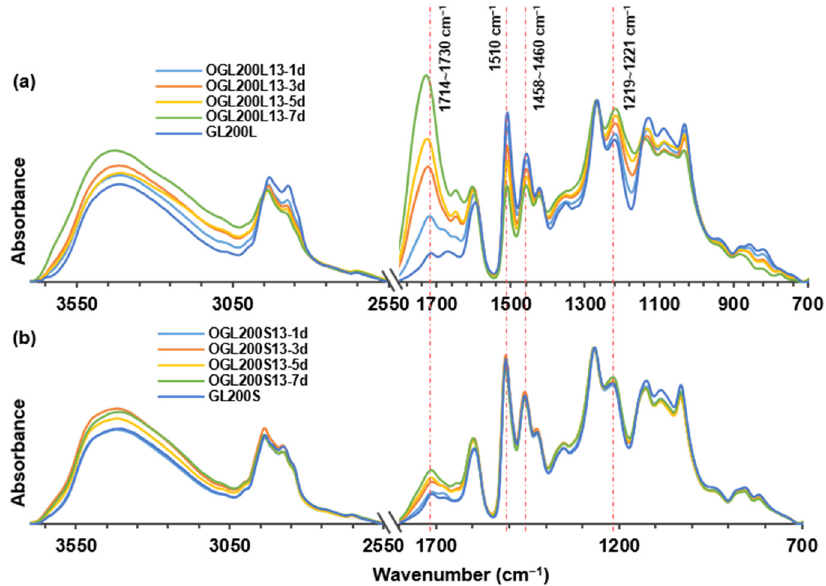
Figure 5. ATR-FTIR spectra of OGLs: ( a ) OGL200L13 series and ( b ) OGL200S13 series as a function of H 2 O 2 treatment time.